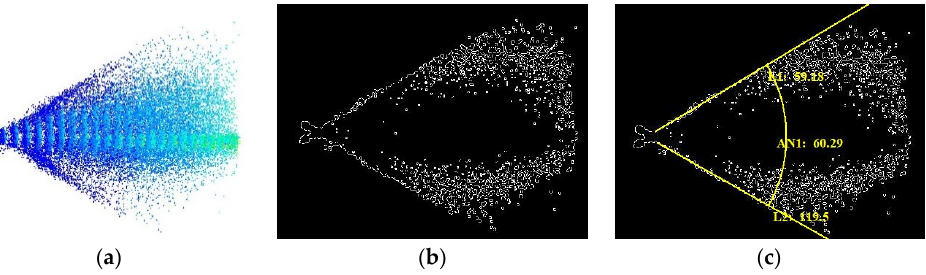
Figure 6. Scattered light imaging of a single droplet. ( a ) Original image. ( b ) Processing image. ( c ) Atomization cone angle.